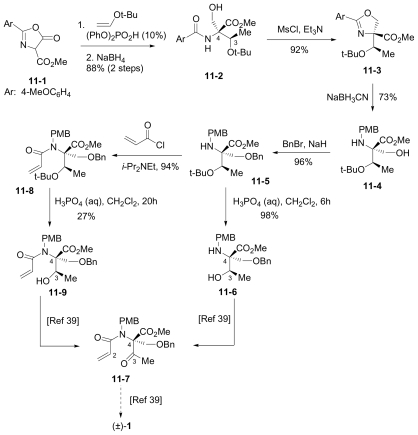
Tepe and Mosey formal synthesis of (±)-1 [49].